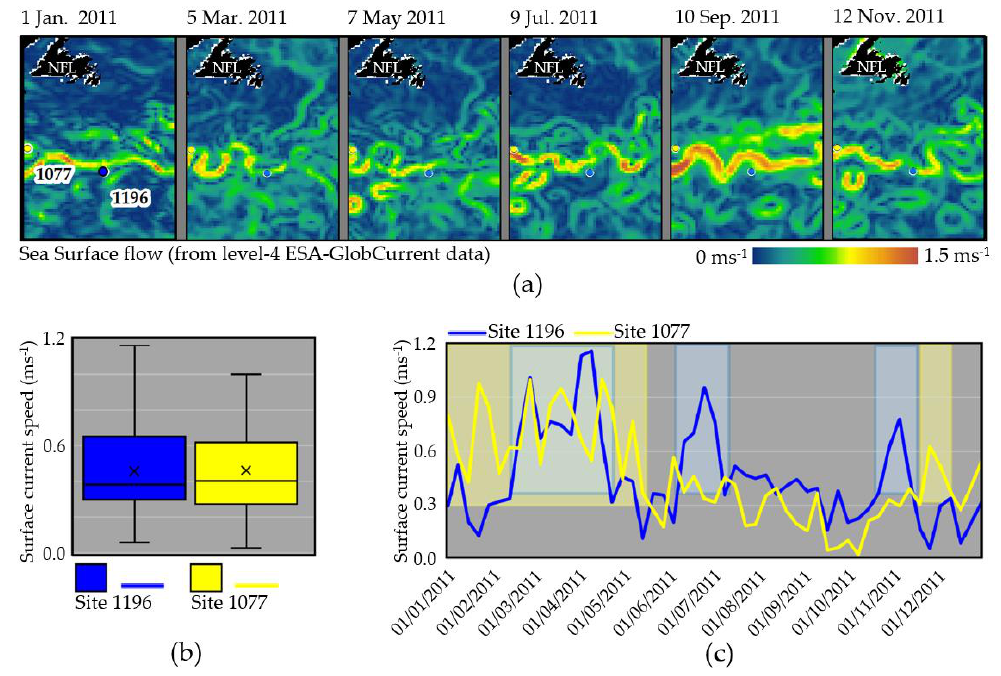
Figure 6. Using the unidirectional nature of time to differentiate statistically equal sites. Panel ( a ) shows a sample of surface water flows off the coast of Newfoundland over 2011, extracted from a year-long 7-day interval hypertemporal dataset of level-4 absolute geostrophic velocity data (from the ESA-GlobCurrent initiative and made available through the Copernicus Marine Core Service). Two sample sites (1077 and 1196) are indicated, from which a 53-measurement time series has been extracted covering 2011 at 7-day intervals. Panel ( b ) shows the statistical summary of both sites, which are equal statistically ( t -test, t = −0.083, p > 0.2). Panel ( c ) shows how the temporal sequence of peaks and troughs can enable the two sites to be differentiated, in spite of their statistical similarity when the ordering provided by time is removed. The three main peaks for site 1196 are highlighted by light blue panels, whilst the two main peaks for site 1077 are highlighted by yellow panels.